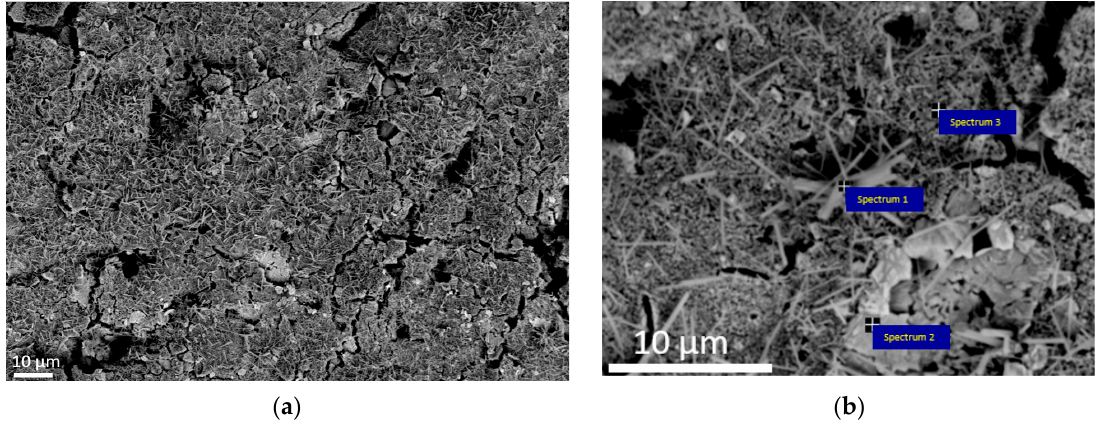
Figure 6. Microstructure of the oxide layer formed on the surface of (Hf,Zr,Ti,Nb,Mo)C ceramic after high-temperature treatment at 1200 °C at various magni fi cations: ( a ) ×2000; ( b ) ×10,000. Table 1. The atomic concentration of the chemical elements on (Hf,Zr,Ti,Nb,Mo)C oxidized surface. Element Content, at % Spectrum